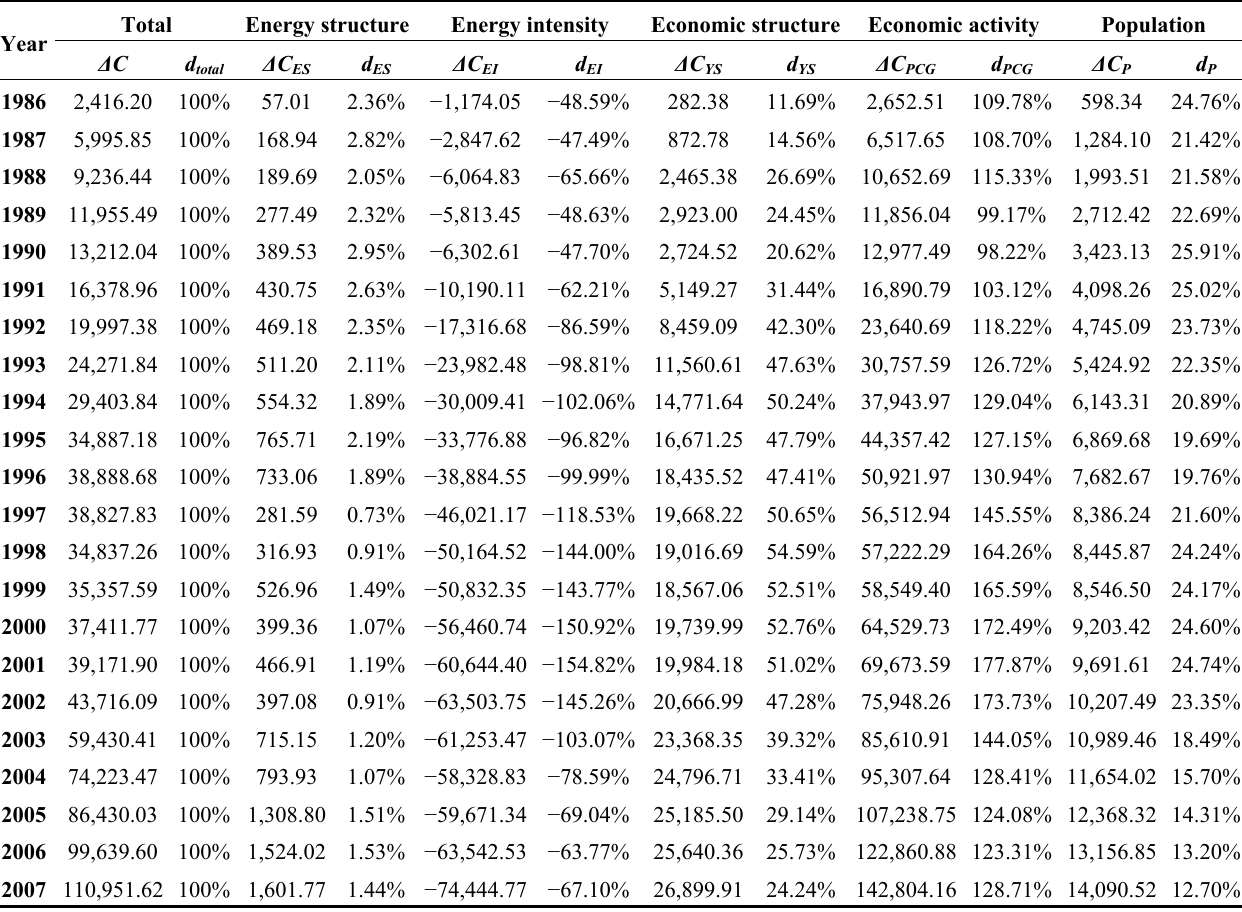
emissions from 1985 to 2